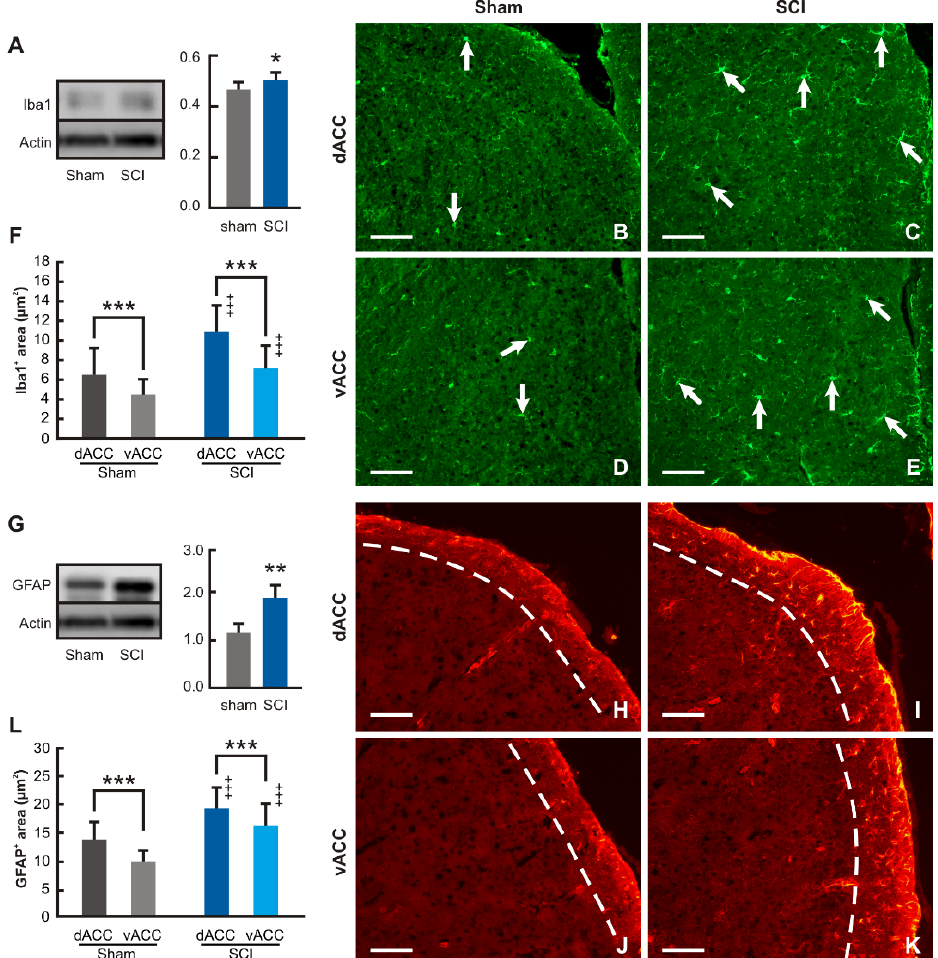
Figure 7. Western blot and immunohistochemical analyses of microgliosis and astrogliosis in ACC. ( A ) Results of Western blot analysis revealed significantly increased levels of Iba1 protein in the mPFC samples removed from SCI- than sham-operated mice (n = 6 for each group; * p < 0.05 vs. Sham). ( B – E ) Representative pictures illustrating Iba1 immunostaining for detection of activated microglial cells in the dorsal and ventral compartments of ACC (dACC and vACC, respectively) from sham- (Sham) and SCI-operated (SCI) mice. More activated microglial cells with typical morphology (arrows) were found throughout both dACC and vACC profiles in SCI- than in Sham-operated mice. Scale bars = 100 µm. ( F ) Image analysis detected significantly higher proportions of Iba1 immunostaining in dACC than vACC in both sham- and SCI-operated animals (n = 6 for each group; *** p < 0.001 vs. Sham). In addition, SCI induced the increase of Iba1 immunofluorescence proportion in both dorsal and ventral compartments of ACC compared with samples from sham-operated mice ( +++ p < 0.001 vs. Sham). ( G ) Results of Western blot analysis revealed significantly increased level of GFAP protein in the ACC samples of SCI- than sham-operated mice (n = 6 for each group; ** p < 0.01 vs. Sham). ( H – K ) Representative pictures illustrate the increased proportion of GFAP immunostaining predominantly in lamina-I delineated by the dashed lines in both dACC and vACC compartments of SCI- compared to those from sham-operated mice, confirming the results of Western blot. Scale bars = 100µm. ( L ) Significantly higher proportion of GFAP immunostaining in lamina-I of dACC than vACC compartments was found in both sham- and SCI-operated mice (n = 6 for each group; *** p < 0.001 vs. Sham). The results of image analysis also demonstrated significantly increased proportions of GFAP immunofluorescence in both dACC than vACC of SCI- than sham-operated mice ( +++ p < 0.001 vs. Sham). Full-length blots are presented in Supplementary Figure S3.